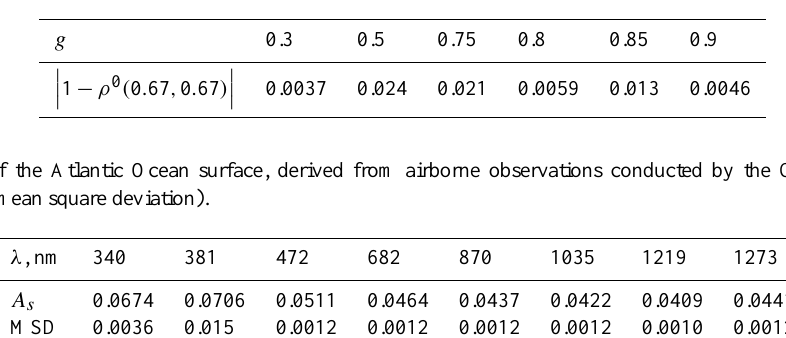
Table 2. Deviation of the zeroth harmonic ρ 0 (0.67, 0.67) of the reflection function from unity.